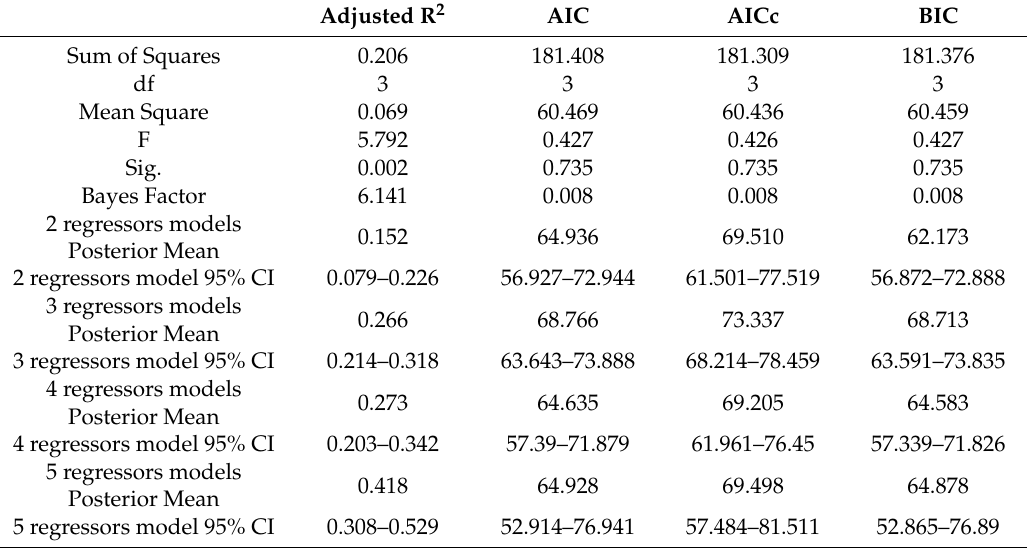
Table 4. Summary of Bayesian ANOVA to test for di ff erences in the mean for Adjusted R 2 , AIC, AICc and BIC across models comprising two, three, four or five parametric regressors.